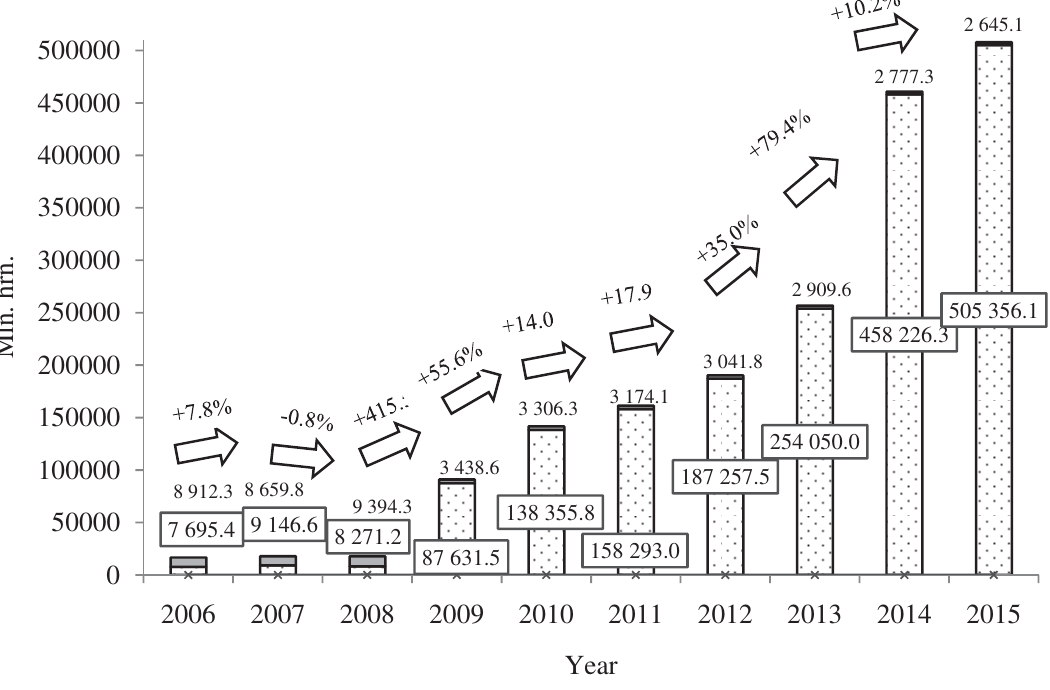
Fig. 5. The dynamics of changes of structure of internal debt over 2006-2015, mln